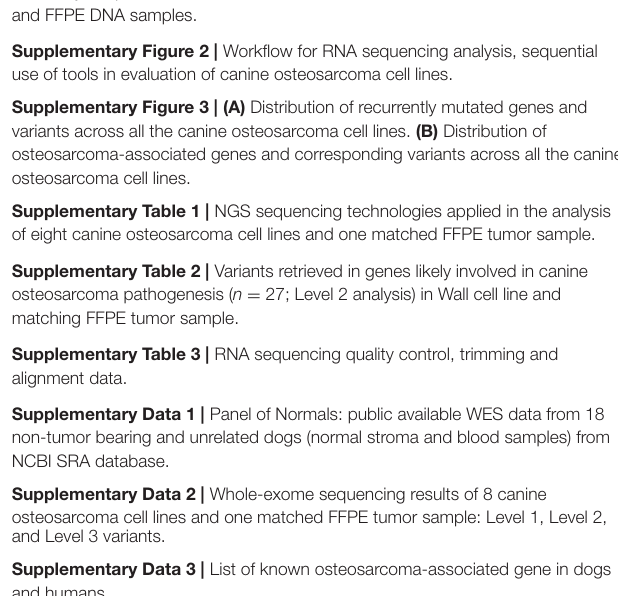
Supplementary Table 3 | RNA sequencing quality control, trimming and alignment